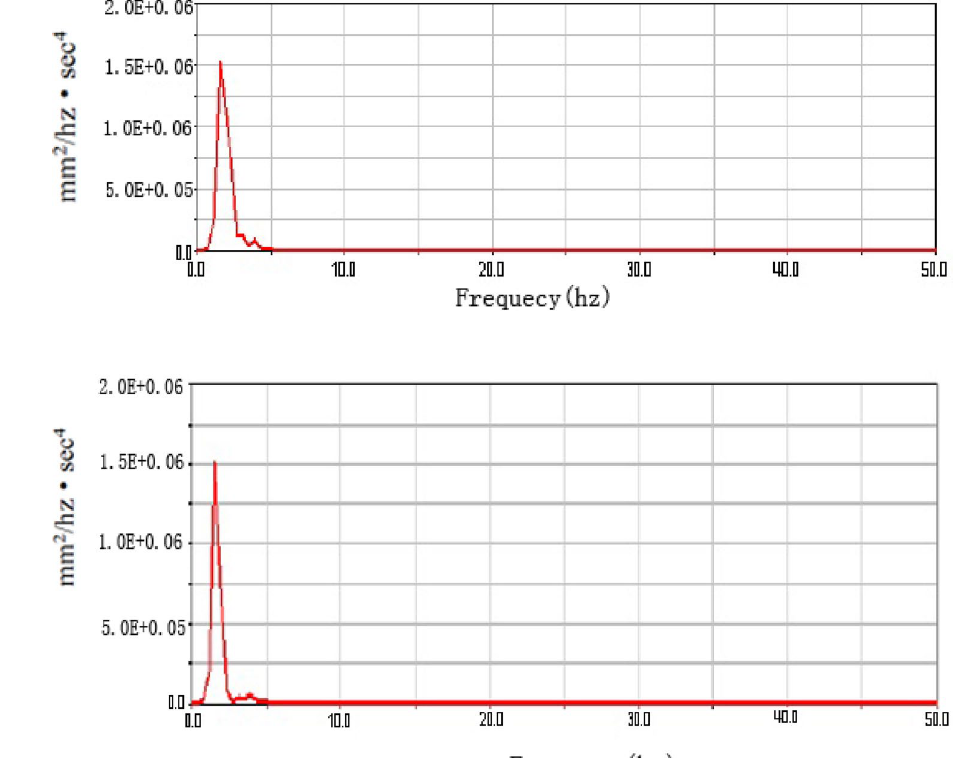
Fig. 6 Test 1. Acceleration Response Curve